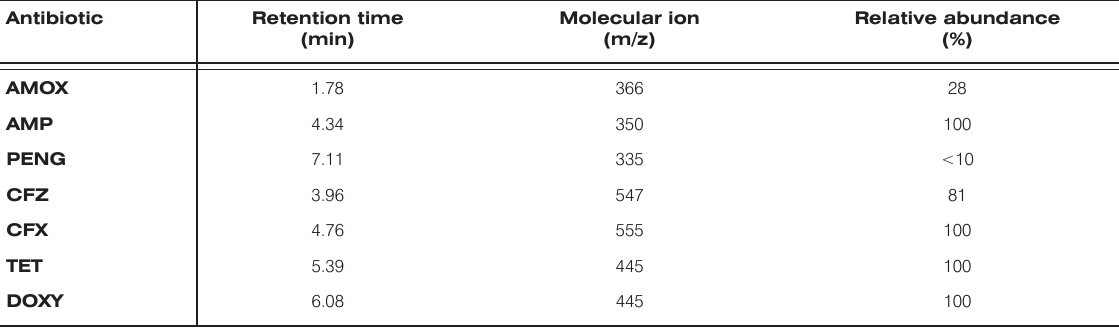
Table 3. The typical retention time, the molecular ion and the relative abundance for the selected antibiotics.